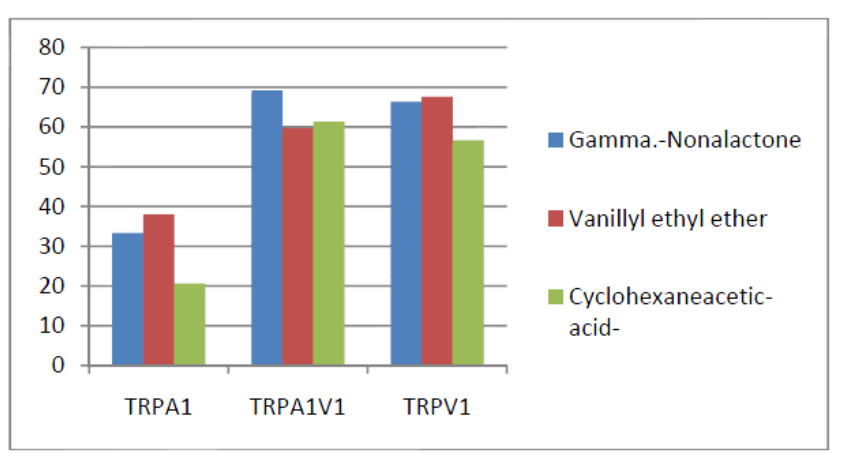
Figure 4. Examples of compounds that activated all three receptors (TRPA1 < TRPA1V1 = TRPV1).